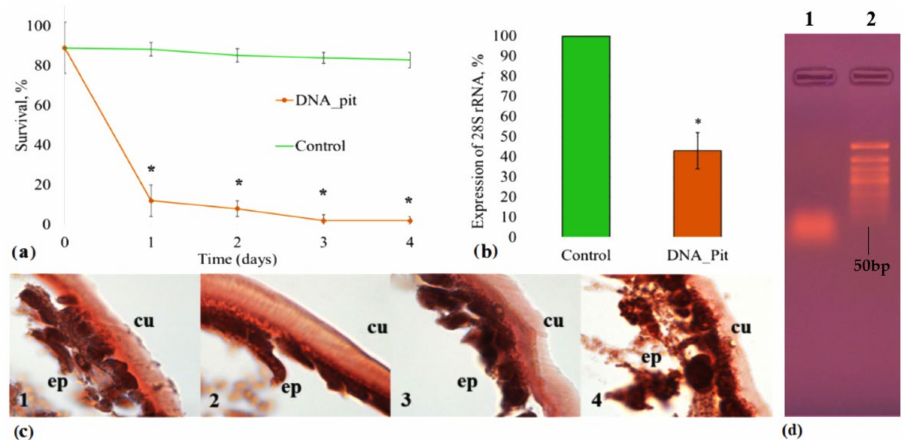
Figure 2. The effect of the plant’s exDNA on C. hesperidum larvae. The C. hesperidum larvae were treated topically with P. tobira exDNA (DNA_pit) or with water (Control). ( a ) Survival rate was calcu- lated; ( b ) expression of 28S rRNA was analyzed by PCR (Control is taken as 100%); ( c ) insect histology (using Congo red) was investigated with light microscopy: 1—Control; 2—ACTG-11; 3—Coccus-11; 4—DNA_pit (explanation in the text); ( d ) electrophoregram (1.8% agarose gel): 1—exDNA of P. tobira leaf surfaces, 2—DNA ladder 50 bp. Means and standard error of means are represented on panels ( a , b ); * is marked when p <